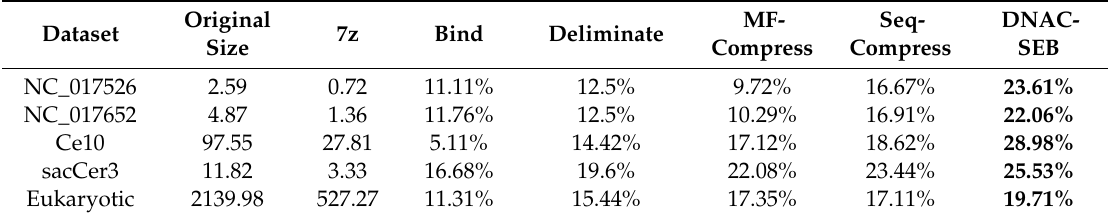
Table 6. Percentage reduction attained by Bind, Deliminate, MFCompress and SeqCompress in comparison to 7z. The sizes of compressed data using 7Z are shown in (MB).